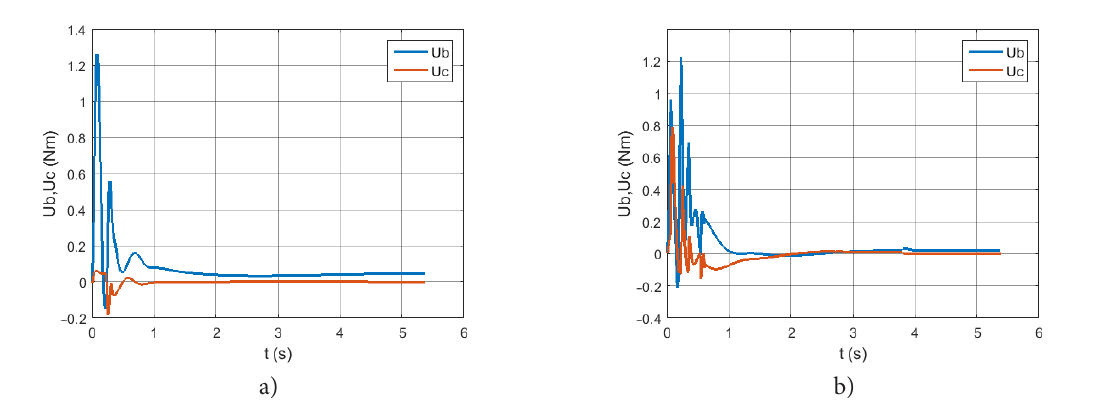
Figure 9. Control moments over time, for: a) LQR, b) PD regulator